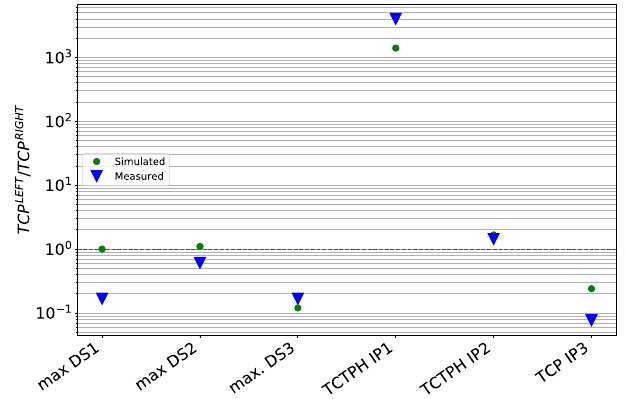
FIG. 10. Simulated (green) and measured (blue) ratio of losses generated by the left and right TCP jaws at 5 σ at different locations. Note that only collimators with BLM signals above the noise level are considered.